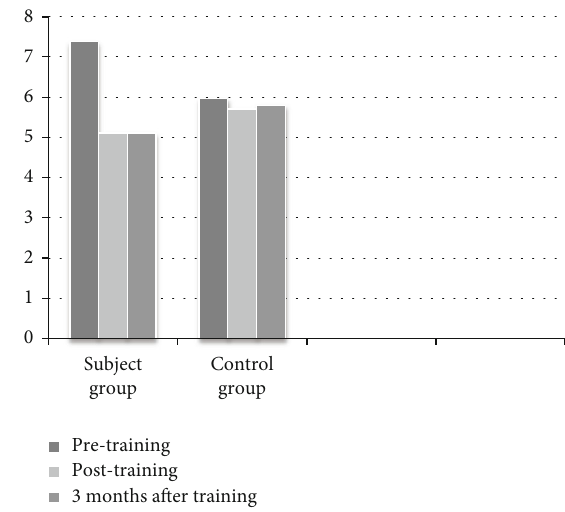
Figure 2: Distribution of scores of participants from the COGNIBOARD test.